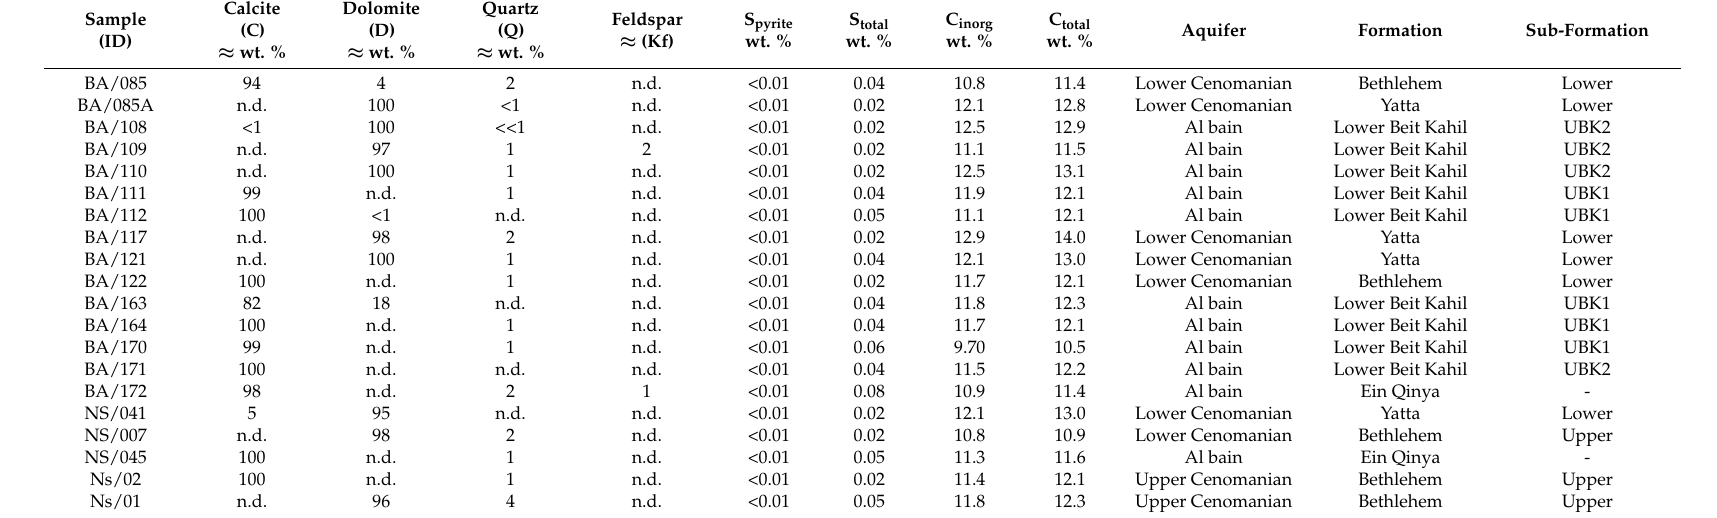
Table 1. Quantitative XRD results, carbon/sulfur measurements, and geological